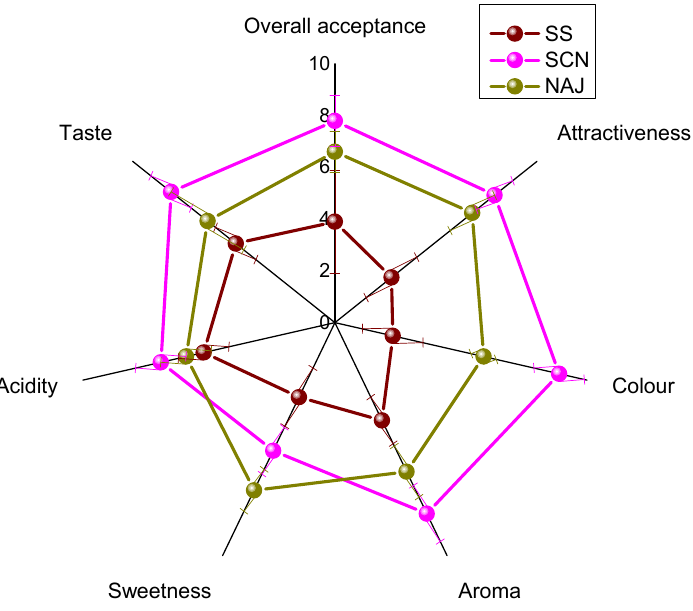
Figure 9. Sensory analysis of the water kefir beverages (fermented sugary substrates). SS, Sucrose solution; SCN, sour cherry nectar, NAJ, natural apple juice.